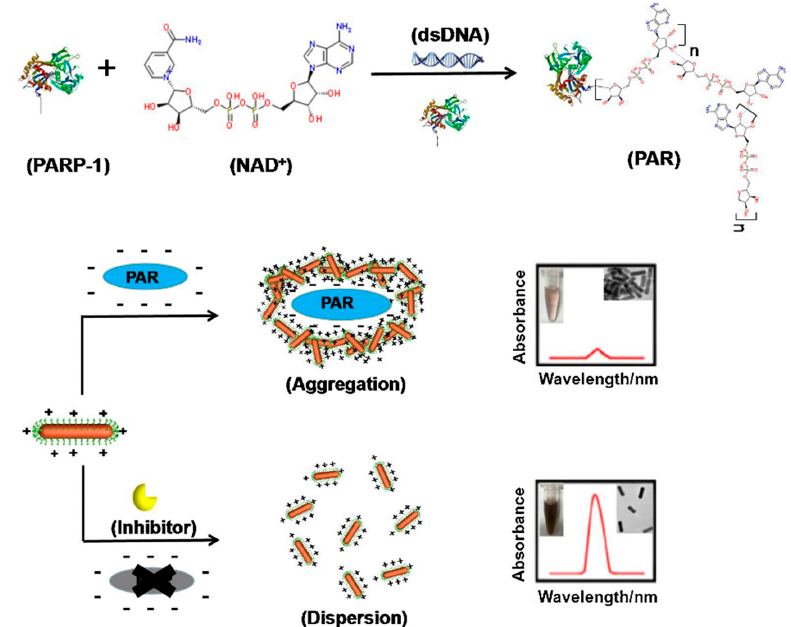
Figure 12. Up: scheme of the formation of poly(ADP-ribose)(PAR), catalyzed by poly(ADP-ribose) polymerase (PARP-1). Down: Scheme of the colorimetric strategy based on AuNRs without and with PARP-1 detector inhibitor. Reproduced from [87] with permission from Elsevier.